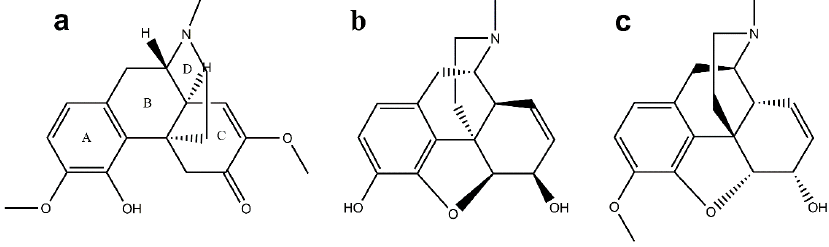
Figure 1. Stereochemistry structure of sinomenine ( a ), morphine ( b ) and codeine ( c ).